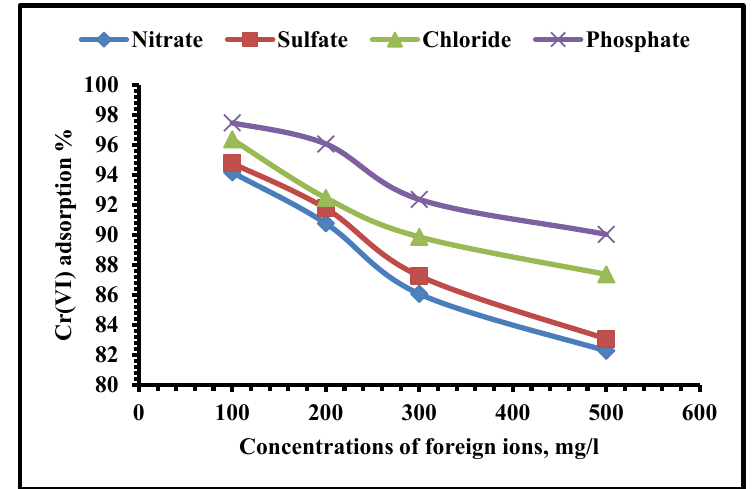
Table 5. Comparison of the physico ‐ chemical properties of the cations.